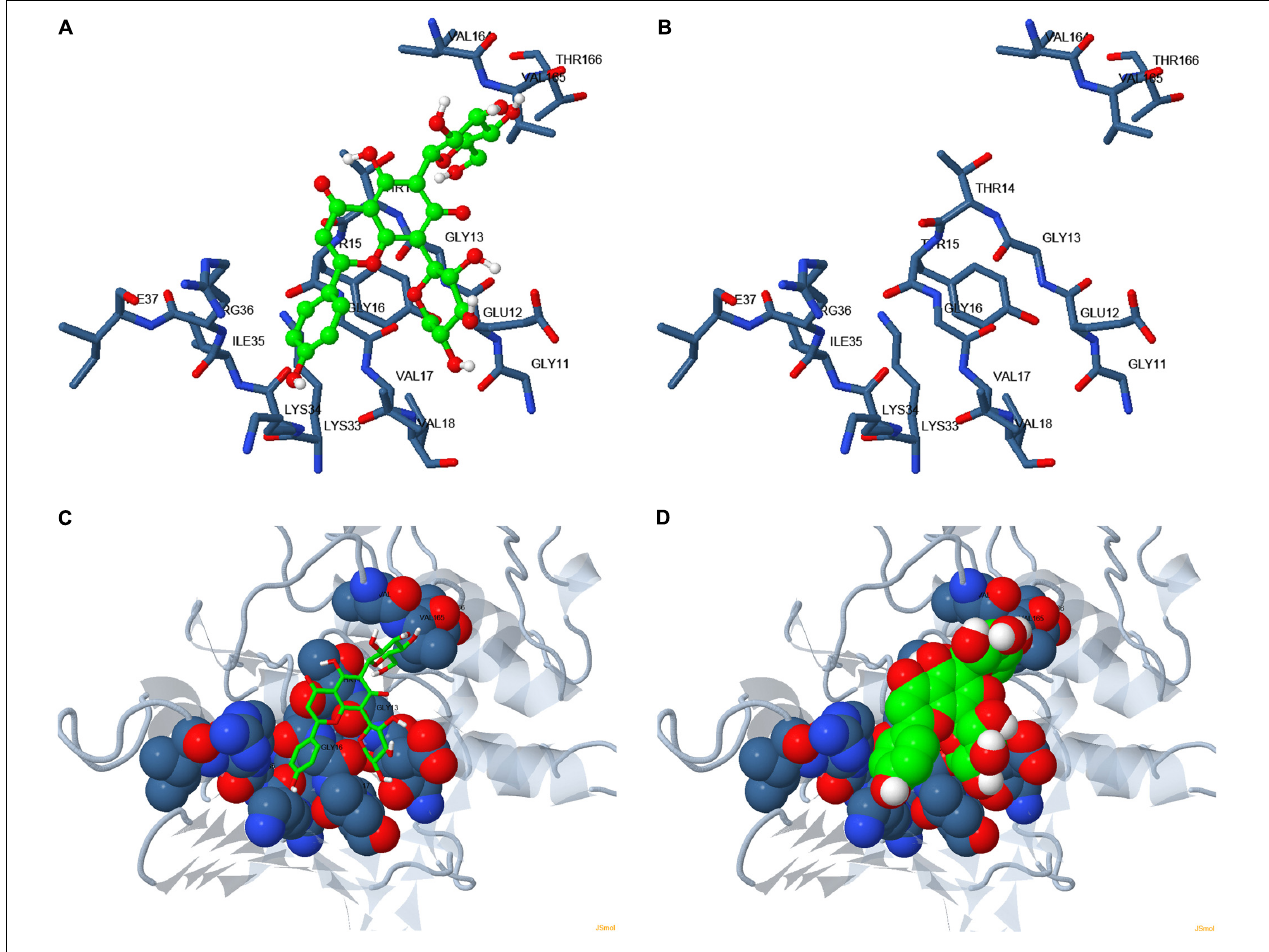
FIGURE 9 | Binding mode of schaftoside to NlCDK1 binding sites. (A,C,D) Schaftoside binding with NlCDK1. (B) The same amino acid residues located close to the binding regions of NlCDK1 as shown in (A) , without binding schaftoside. Carbon atoms in NlCDK1 and schaftoside are shown in blue and green, respectively. Colors of other atoms are as follows: oxygen (red), nitrogen (light blue). In (C,D) , gray color represented for non-binding regions of NlCDK1 (local spacial